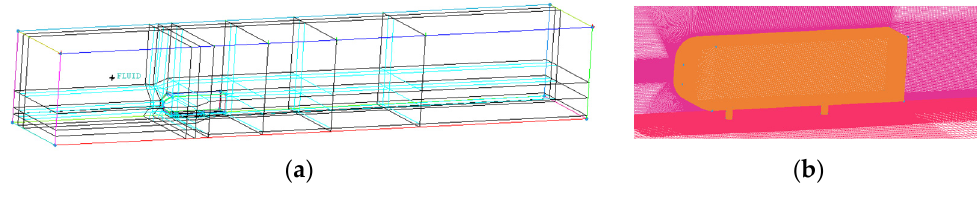
Figure 2. Computational domain and boundary conditions.